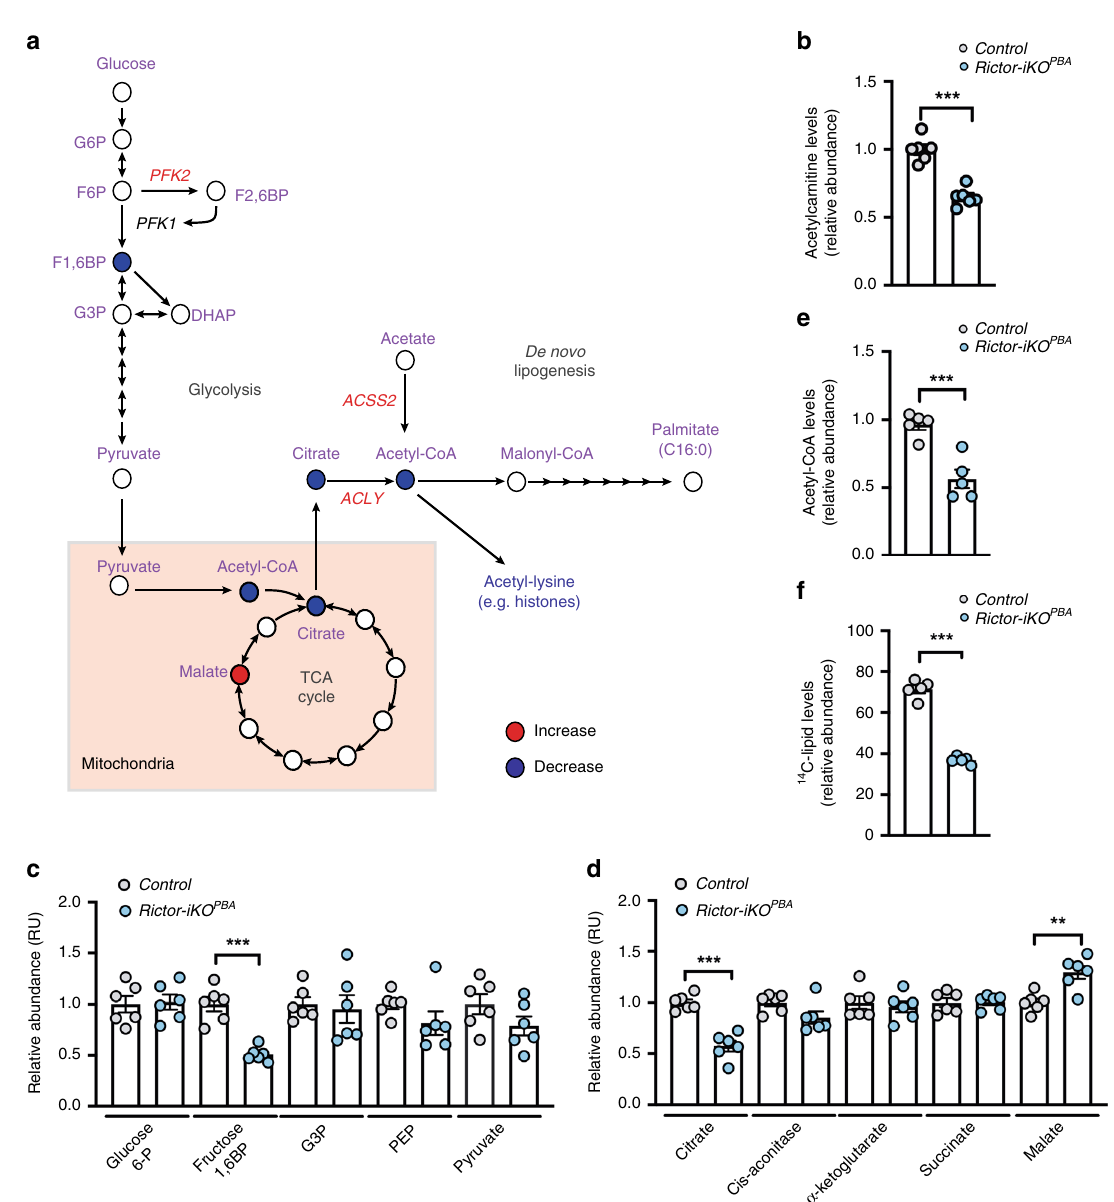
Fig. 2 mTORC2 regulates acetyl-CoA levels and glucose-dependent fatty acid synthesis. a Schematic of metabolic pathways and individual metabolites regulated by mTORC2. Blue- fi lled circles correspond to metabolites that signi fi cantly decrease in abundance in Rictor-iKO PBA cells; red- fi lled circles indicate a signi fi cant increase in abundance. Enzymes labeled in red are those identi fi ed in this study as being regulated by mTORC2. b , c Bar graph representations showing the average relative abundance of acetylcarnitine ( b ), glycolytic ( c ), and TCA cycle ( d ) intermediates ( n = 6 per group). e Direct acetyl-CoA measurements using control and Rictor-iKO PBA cells ( n = 5 per group). f De novo lipogenesis assay measuring D-[U- 14 C]-glucose labeling of de novo synthesized lipids ( n = 5 per group). Bar graphs represent mean ± SEM. ** p < 0.01 and *** p < 0.001. Statistical signi fi cance was calculated by using two- tailed unpaired Student ’ s t test ( b , e , f ) or two-way ANOVA with Sidak ’ s test multiple comparisons ( c , d